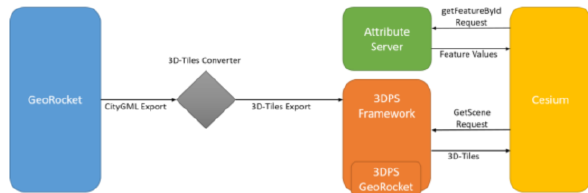
Figure 2. The data-flow from GeoRocket to the visualized 3D Tiles, which are requested via the 3D Portrayal Service queries (source: Koukofikis et al, 2018)